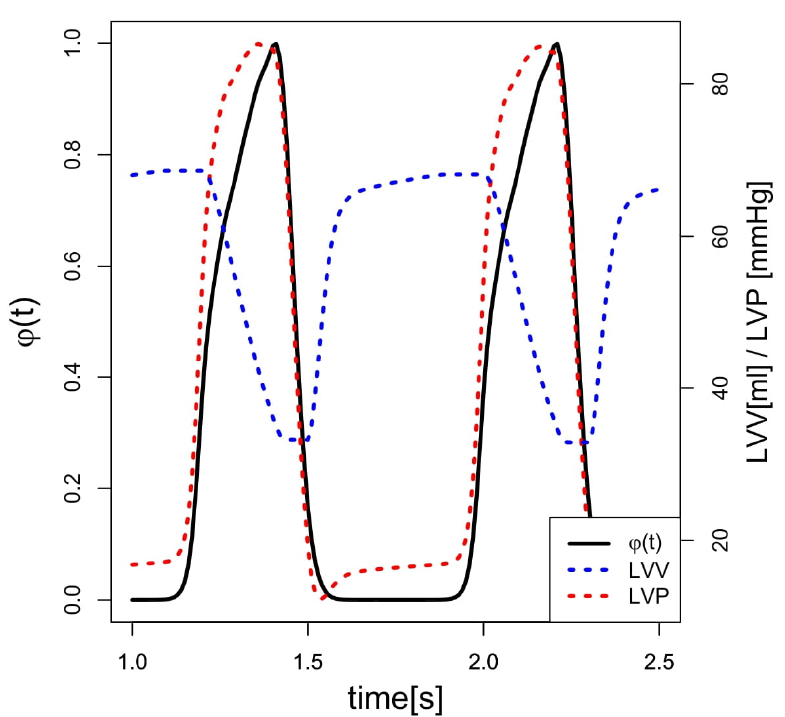
Figure 3. Activation function. Simulated activation function ( φ (t)—black), consecutive left ventriular volume (LVV—blue), and left ventricular pressure (LVP—red) in animal 4.